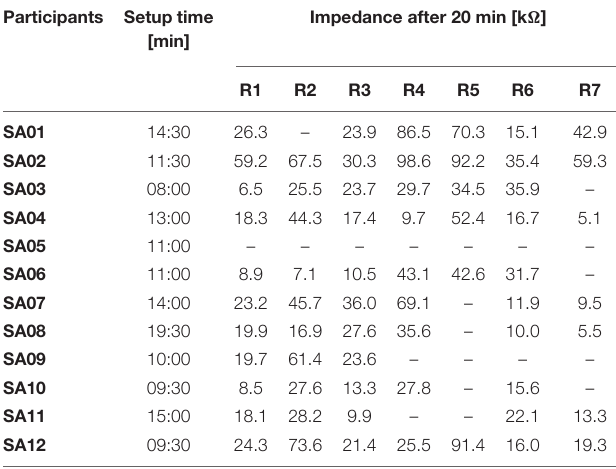
FIGURE 6 | Example showing a single annotated sleep spindle of participant P4, captured by the PSG system ( top , channel C4_M2) and trEEGrid channels R5 (middle) and R1-R7 (bottom) .